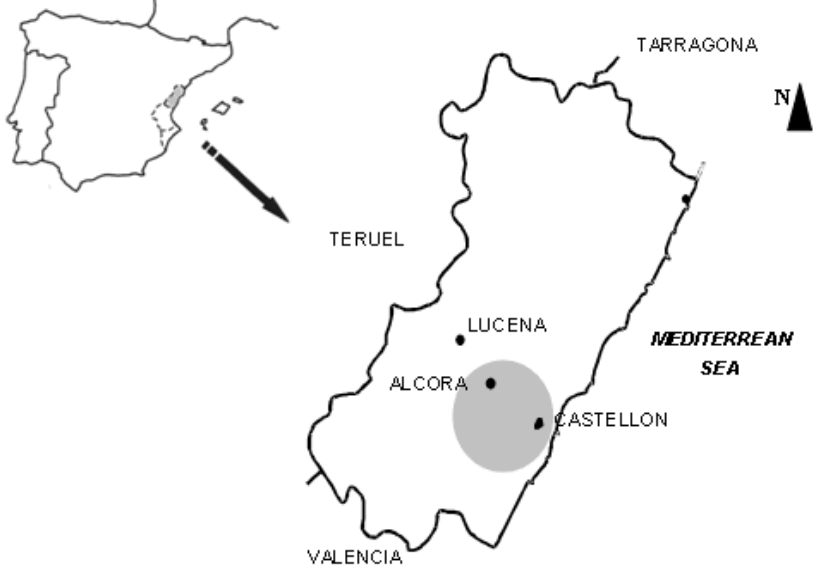
Figure 1. Location map of three different environments: urban (Castellón), industrial (Alcora) and rural (Lucena).